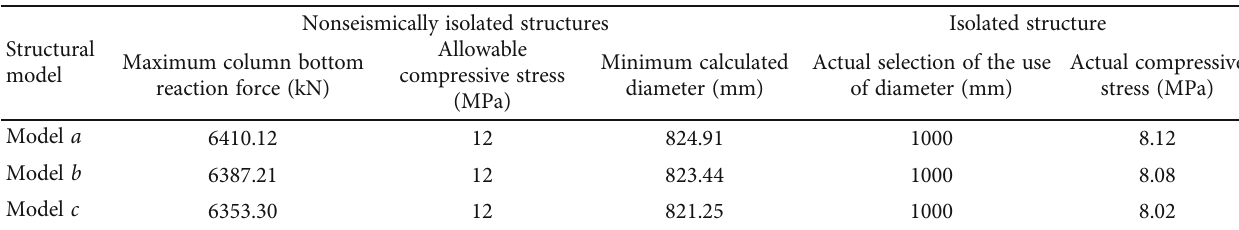
Table 2: The parameters of the isolated bearing.